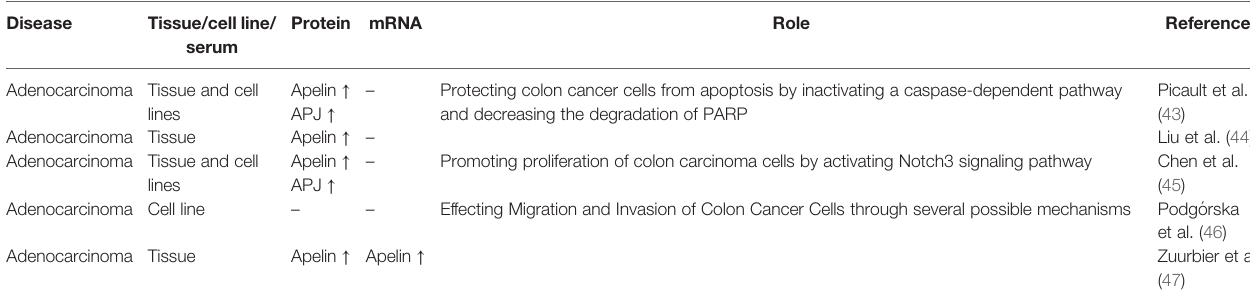
TABLE 2 | Expression and role of apelin/APJ signaling in colon cancer.